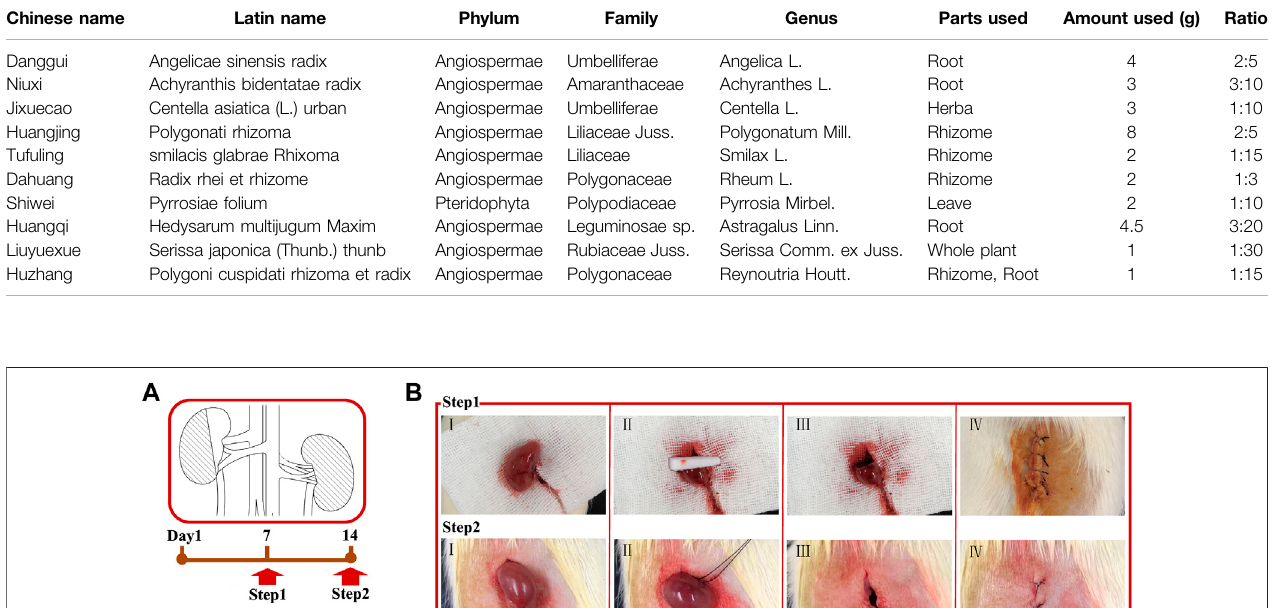
Frontiers in Pharmacology |